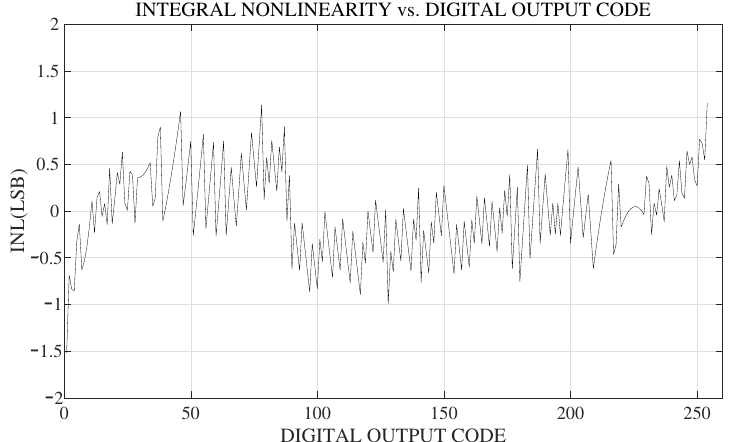
Figure 19. The INL of the SAR